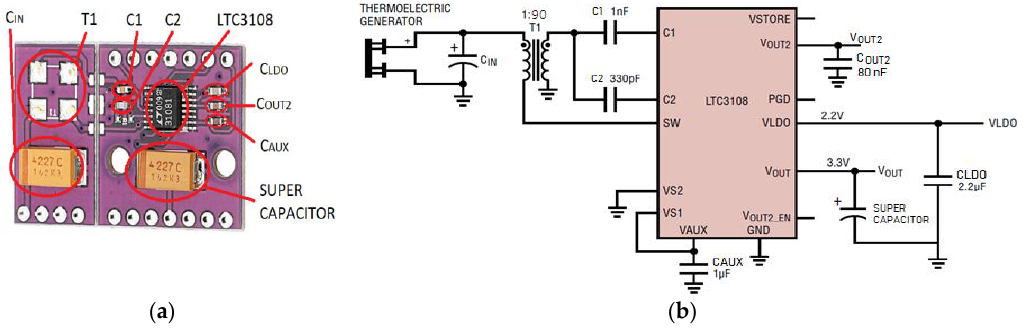
( c ) Figure 5. Top view of TEC1-12706 ( a ) (Thermonamic Inc.), TMG-127-1.4-1.2 (Ferrotec Nord Corp . ) ( b ), and TES1-03102 MINI (Welletech Inc.) ( c ).